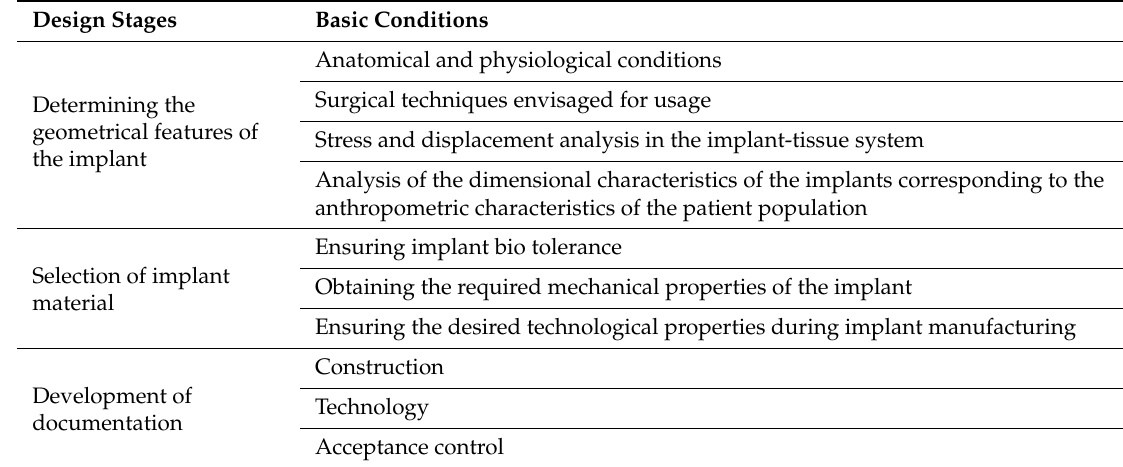
Table 8. General guidelines for the design of the